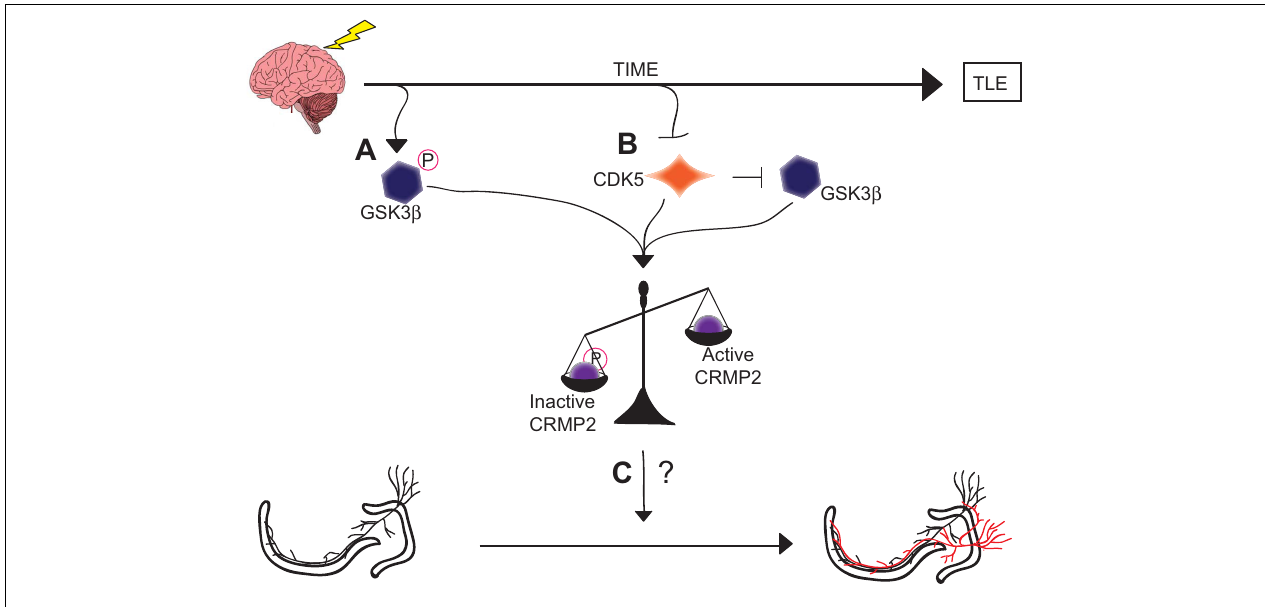
FIGURE 8 | Graphical summary of findings. (A) GSK3 β is phosphorylated and thereby inactivated in the early phases following injury. This inactivation leads to decreased amounts of phosphorylated (inactive) CRMP2. (B) CDK5 phosphorylation of CRMP2 is decreased in the later phases following injury. This decrease in phosphorylation also